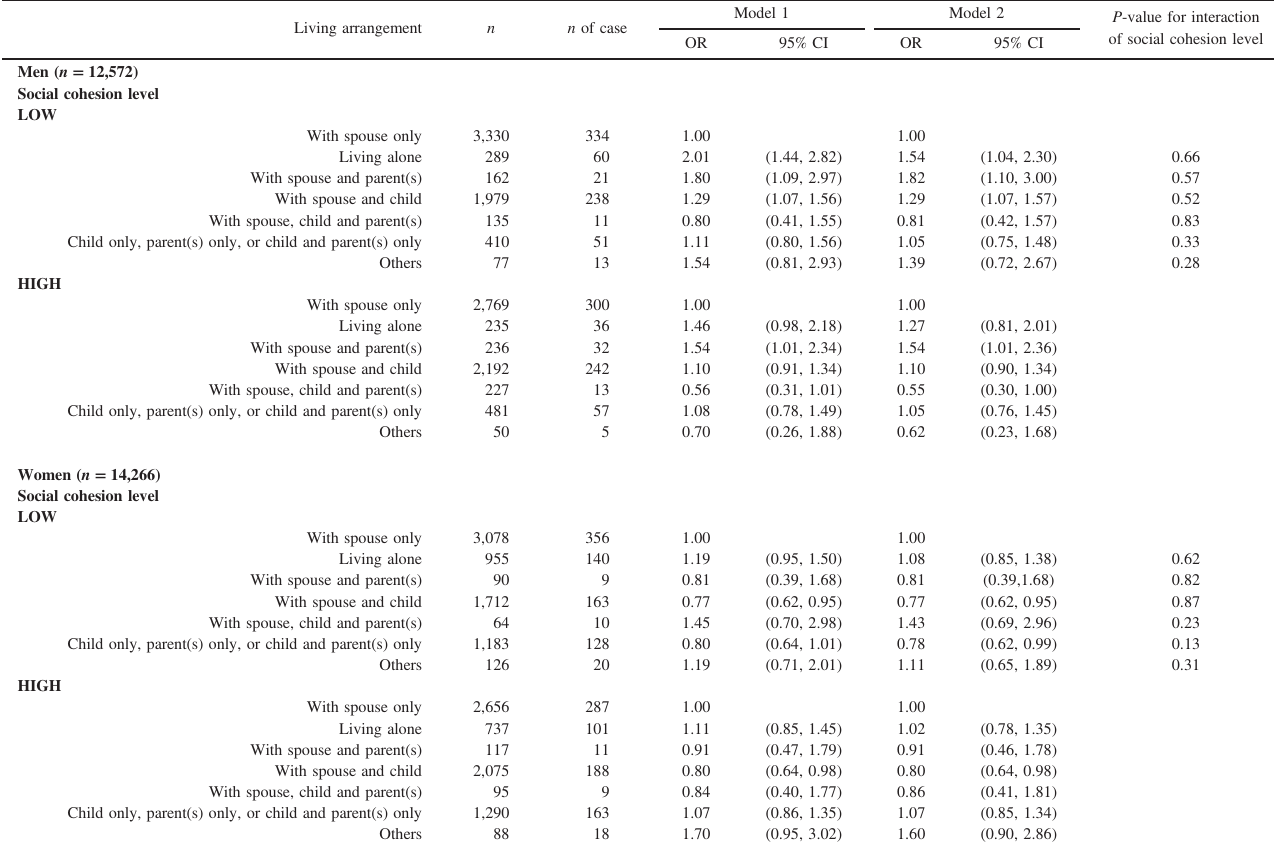
Table 4. Gender-speci fi c adjusted odds ratios of living arrangement for depressive symptoms by social cohesion level among men